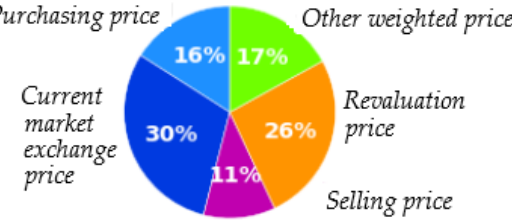
Figure 9. Answers for question of how to disclose the values of cryptocurrencies in accounting? This percentage of the respondents stated that entities holding cryptocurrencies should